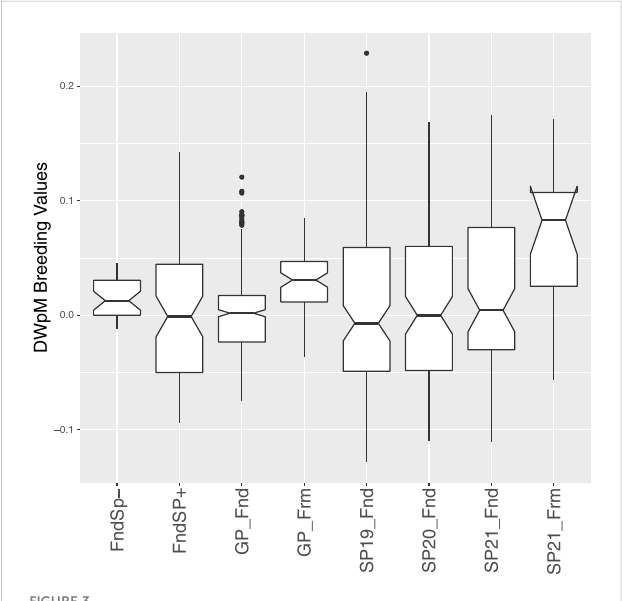
0.10.00.10.2 FIGURE 3 Box plots of estimated breeding values of DWpM (Dry Weight per Meter, log transformed) for 517 GPs and 436 SPs. The SPs included these subcategories: Founder SPs without progeny (these SPs were collected from the wild but did not produce GP progeny, denoted FndSP – ), Founder SPs with progeny (FndSP+), SP19_Fnd (SPs tested on farm in Yr2019 generated using GPs from Founders), SP20_Fnd (SPs tested in Yr2020), SP21_Fnd (SPs tested in Yr2021), and SP21_Frm (SPs tested in Yr2021, generated using GPs collected from SPs tested on farm in Yr2019). The GPs included GPs collected from Founders (GP_Fnd) and GPs collected from SPs tested on farm in Yr2019